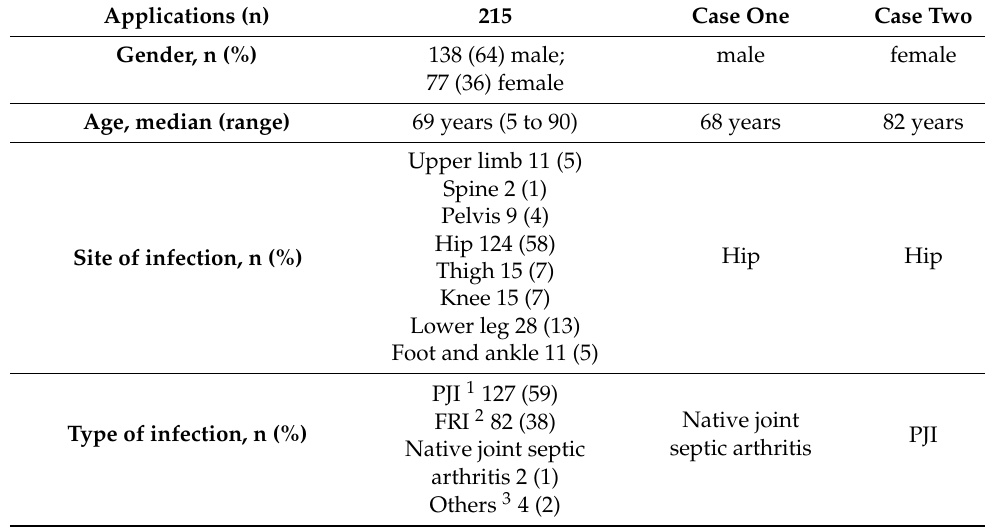
Table 1. Demographic and surgical data of the patient series